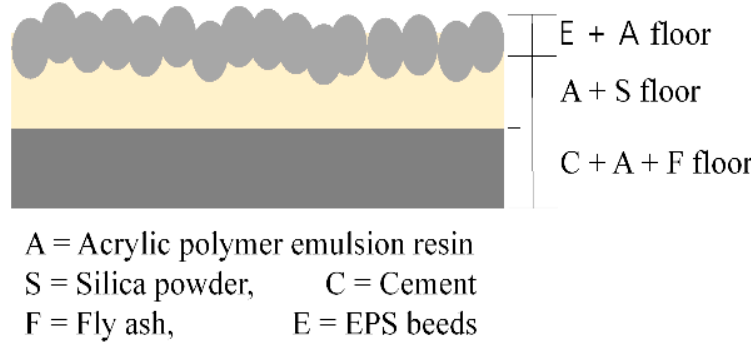
Figure 2. Schematic diagram of the place-type resilient material.